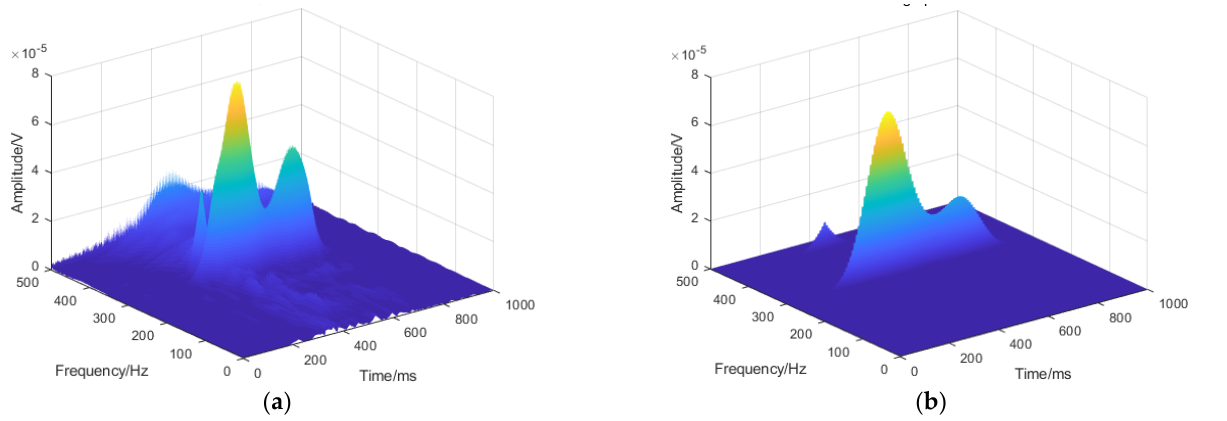
Figure 5. 3D time-frequency-amplitude diagram of the sEMG signal: ( a ) 3D time-frequency-amplitude diagram of the ST and ( b ) 3D time-frequency-amplitude diagram of the STFT.